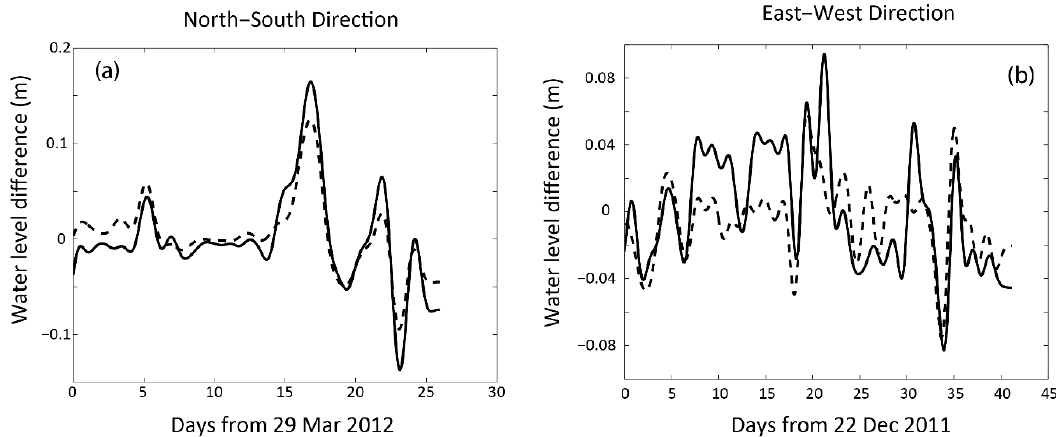
Figure 9. Water level differences from observations and calculations: ( a ) in the north-south direction and ( b ) in the west-east direction. The solid lines are observations and the dashed lines are from calculations.